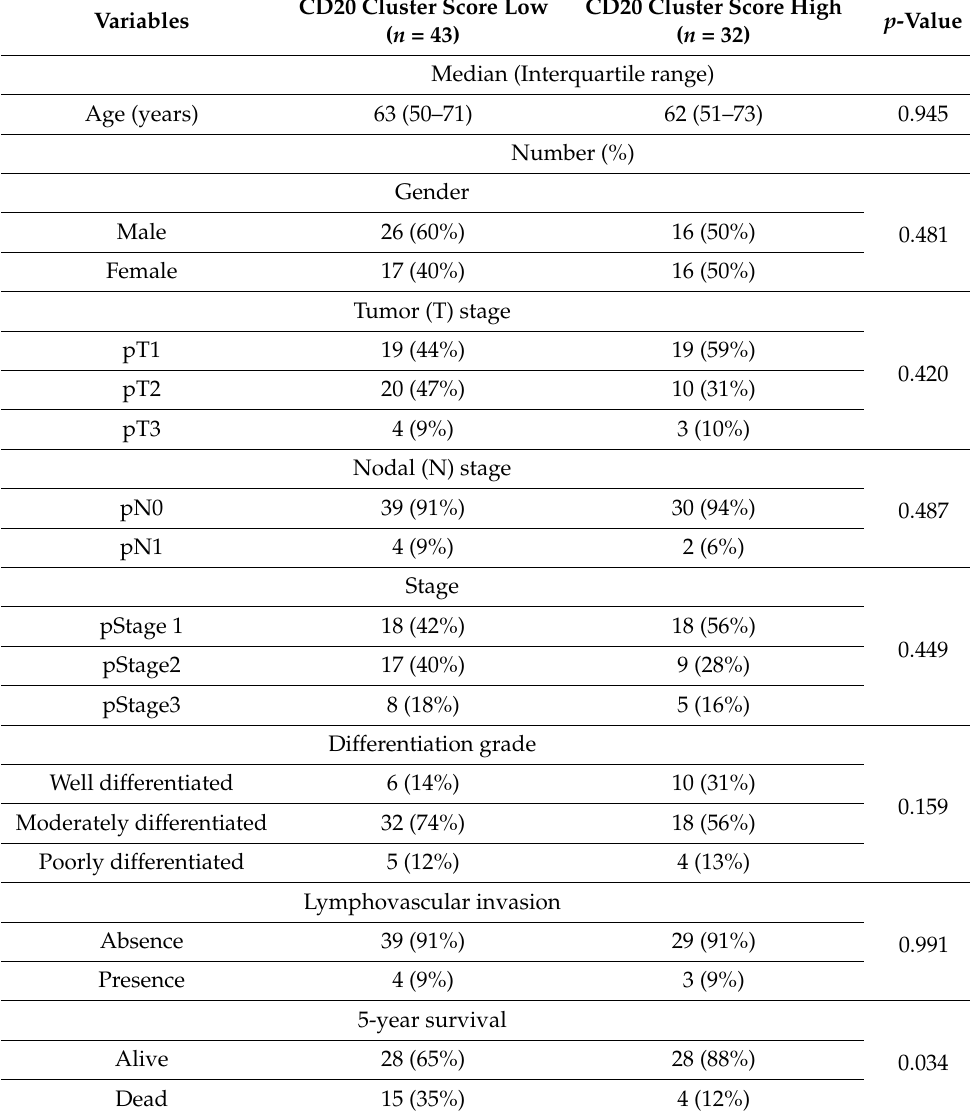
Table 1. Clinicopathological characteristics a